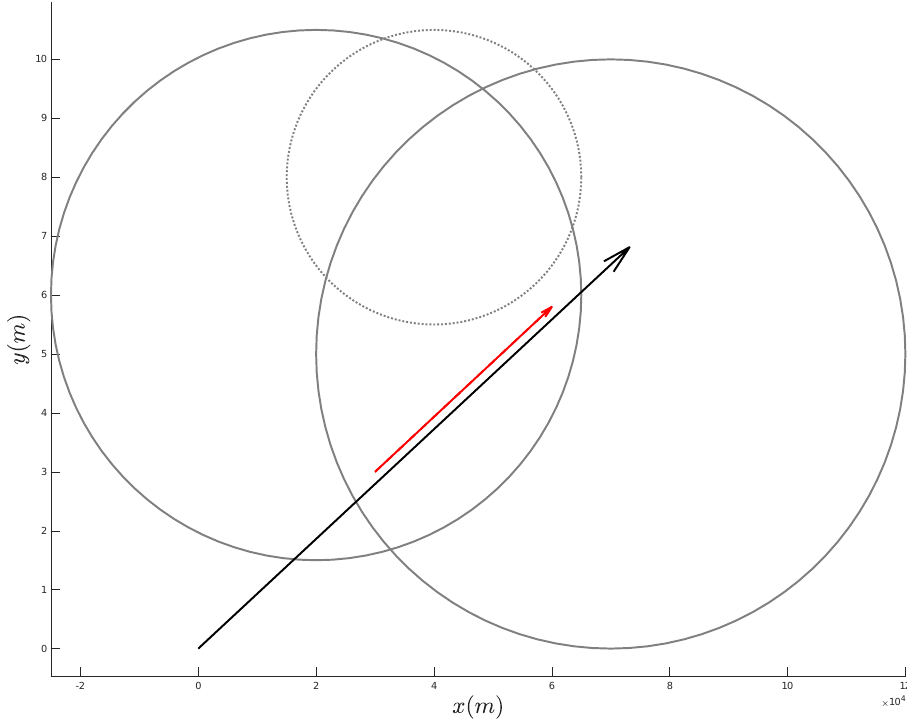
Figure 2. Scenario considered in the experimental analysis. We assume additional information is available, in that the target’s trajectory is known to be confined in the intersection of the two solid circles and to lie outside the dotted circle. The red (shorter) arrow represents the target’s trajectory. The APF direction is shown with a black (longer) arrow.